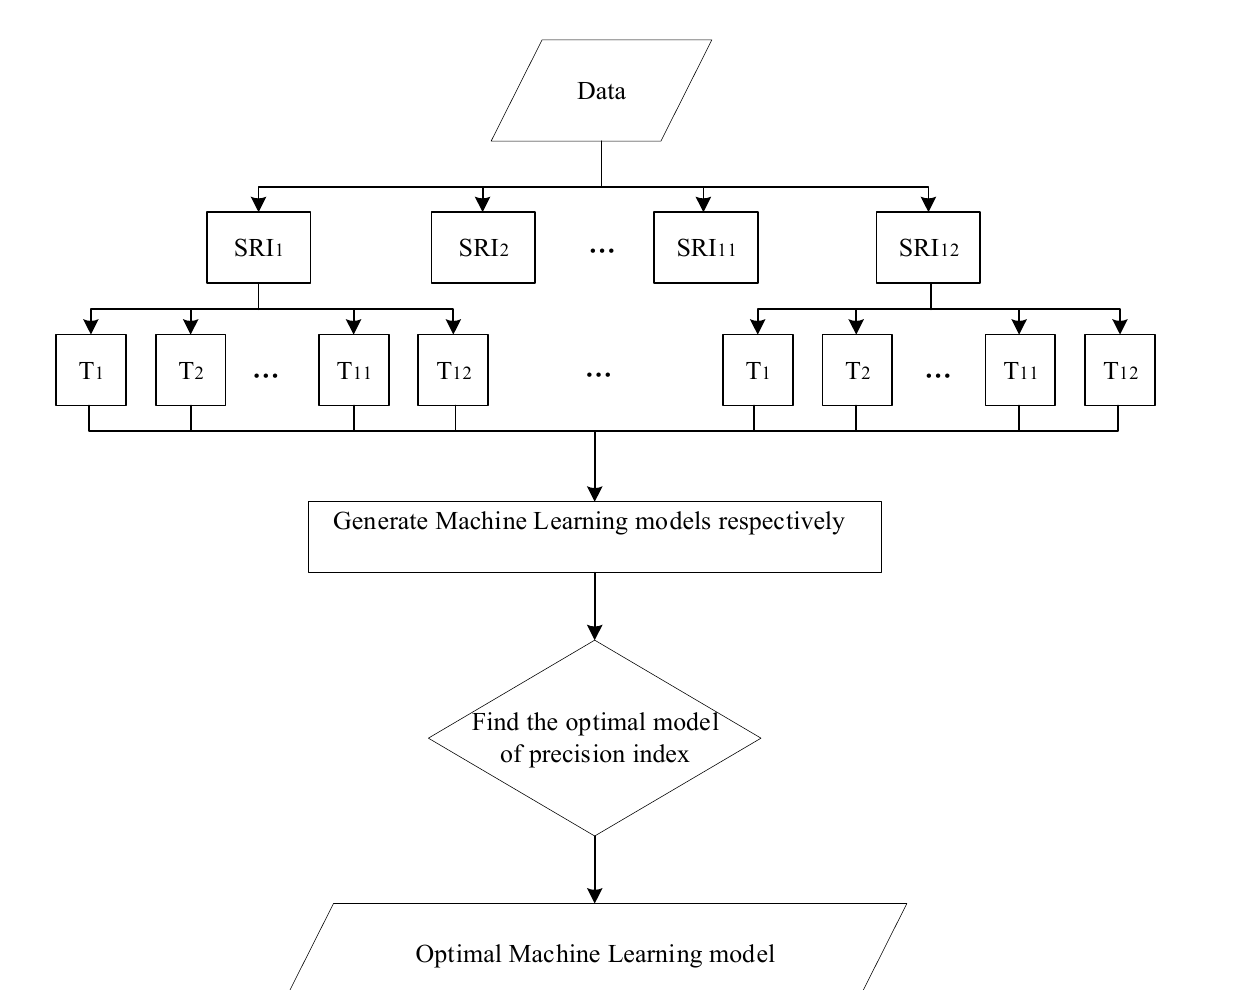
Figure 6. Flow chart of the 12 × 12 grid search method.